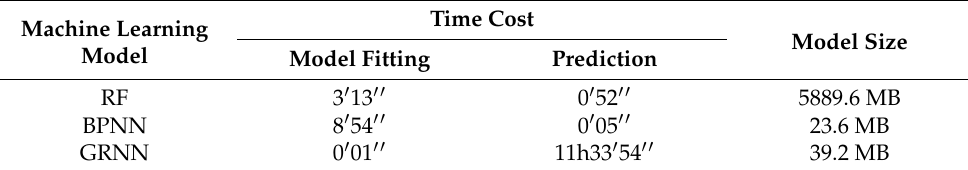
Table 4. Time costs for model fitting and prediction and model size of different machine learning